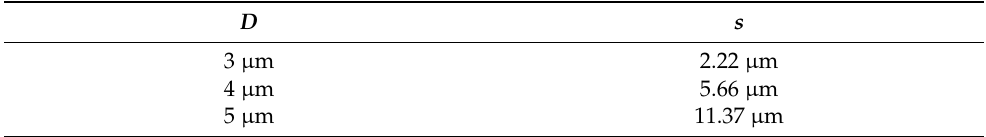
Table 1. Sliding distance of different microparticle sizes.